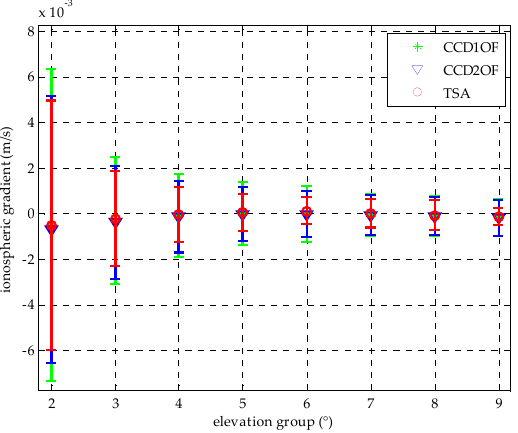
Figure 8. Comparison of the mean and deviation of the estimation between CCD-1OF, CCD-2OF and TSA.